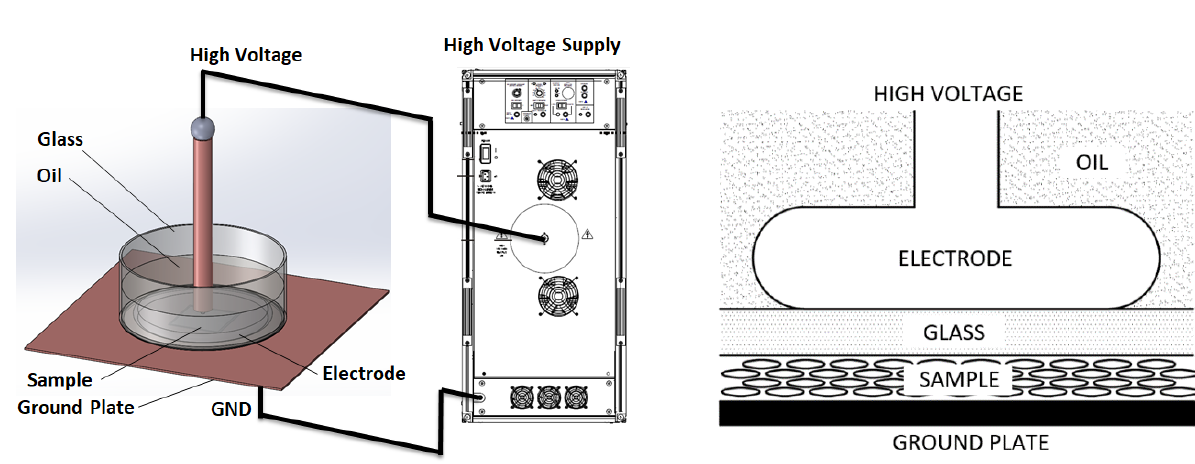
Figure 5. Experimental setup with a dielectric layer of glass and the high-voltage electrode surrounded by oil to avoid surface discharges.